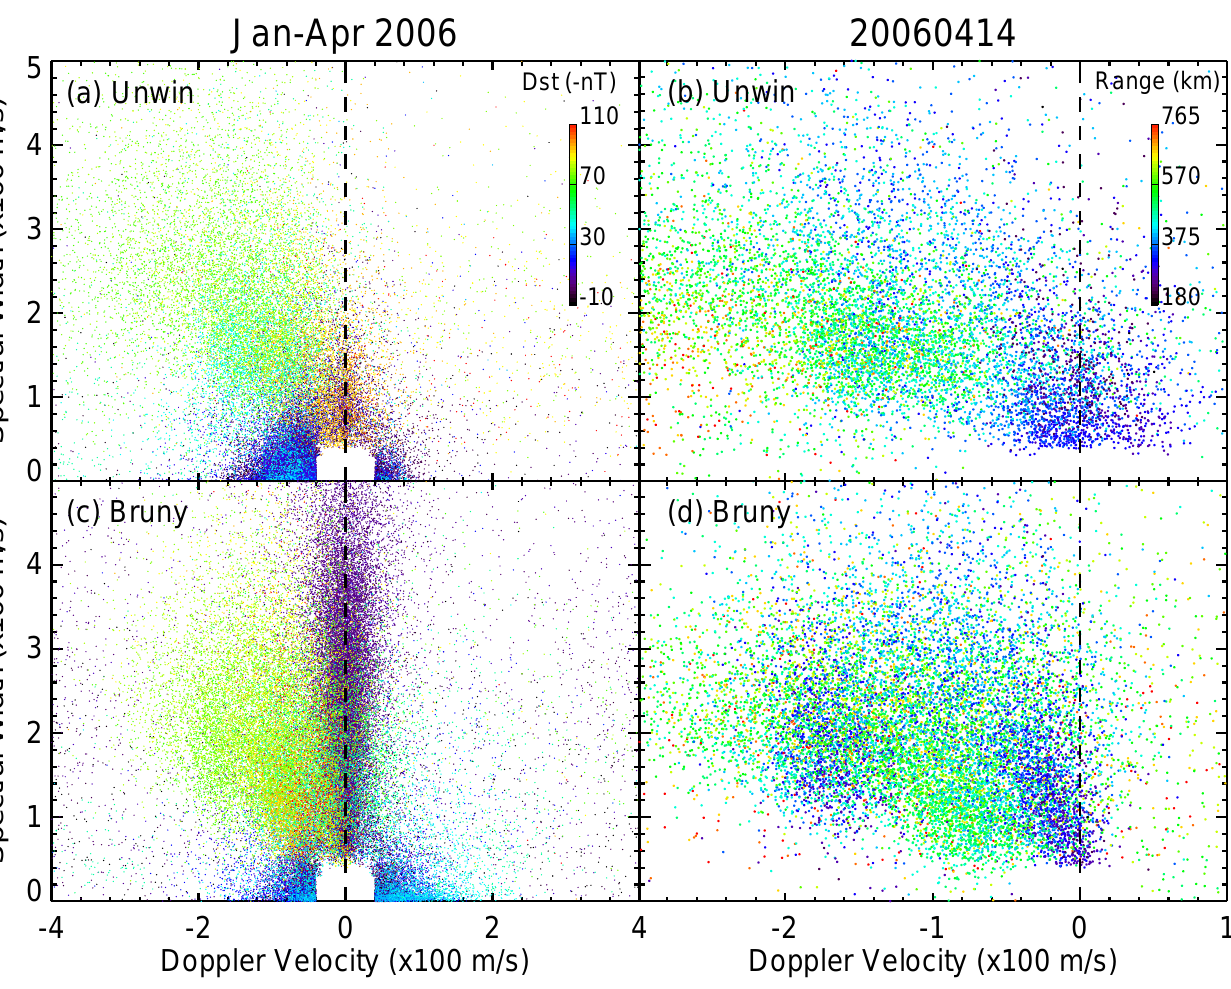
Fig. 7. Spectral width versus Doppler velocity scatter plots for the (a) Unwin and (c) Bruny Island radar data. The data were collected in the evening sector in January–April 2006 and colour-coded in D st index as indicated in panel (a). Panels (b) and (d) show the data collected with the Unwin and Bruny Island radar, respectively, during the 14 April 2006 storm event. The points are colour-coded in slant range as indicated in panel